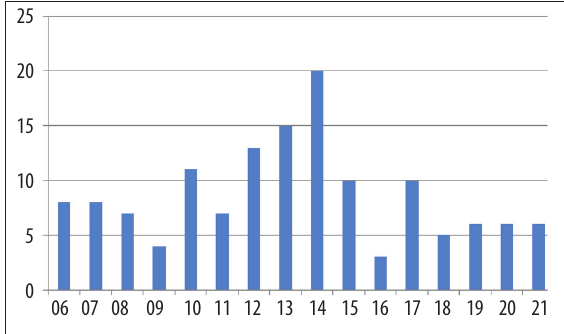
Fig. 7. Average summer day 2009 peak period (arrival and